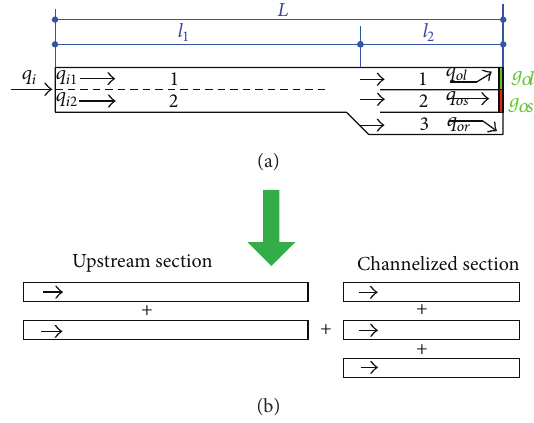
dynamic and insufficient split, endogenous flow of basic road, and the spillover of channelized section. 3.1. Dynamic and Insufficient Split. Usually oversaturation is developed gradually and queue back extends cycle by cycle, that is, domino phenomenon is the result of oversaturation extending in several cycles as shown in Figure 7(a). Each green signal tends to pull back queue back while each red signal prolongs queue back. Furthermore, the length pulled back or prolonged is proportional to time duration of traffic signal because in the figure slope of wave trajectory; that is, wave speed including starting wave and stopping wave is